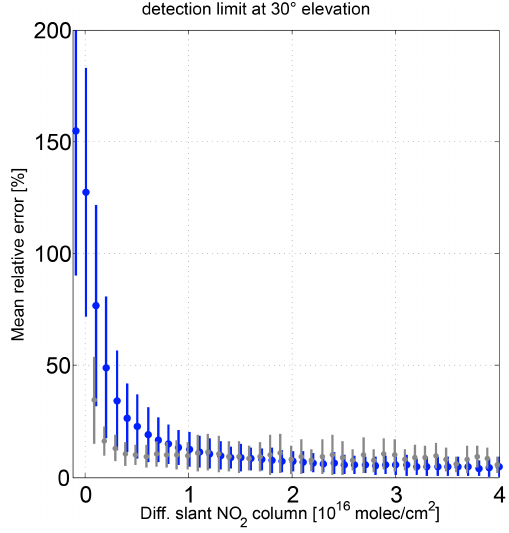
Figure 2. Mean relative error of the fitted differential slant NO 2 col- umn as a function of the differential slant NO 2 column. Error bars in this figure indicate 2 times the root-mean-square deviation. Blue refers to results obtained from individual spectra (integration time 30s) and gray refers to results obtained after averaging all differen- tial slant column fits (for this elevation) obtained within 1h. These results only include spectra taken at 30 ◦ elevation (with the zenith spectrum as a